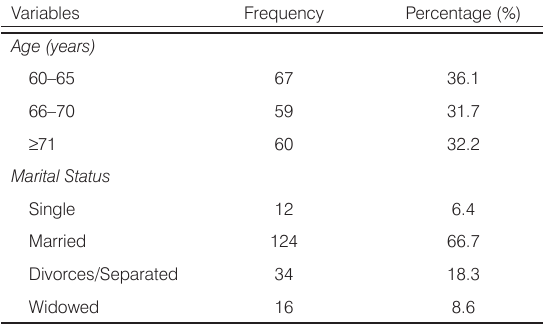
Table 1. Percentage distribution of age and marital status of respondents ( n =